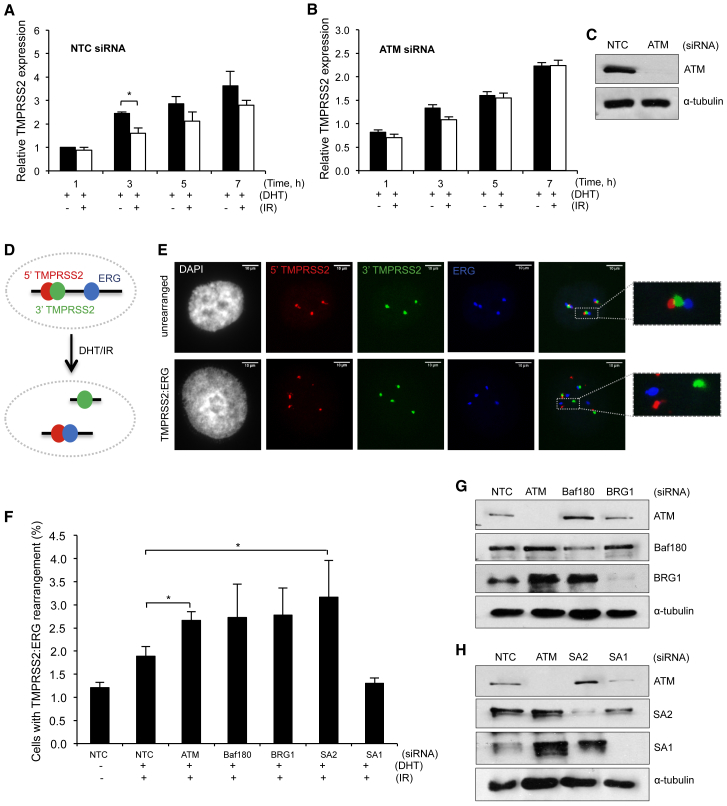
Depletion of Cohesin or PBAF Leads to Increased Chromosome Rearrangements in the TMPRSS2 Gene Following Transcriptional Induction and DNA Damage(A and B) qRT-PCR analysis of relative TMPRSS2 transcript levels in LNCaP cells following transcriptional induction with 300 nM DHT (+DHT) and with or without 10 Gy irradiation after siRNA depletion with non-targeting control (NTC; A) or ATM (B). Data are presented as the mean ± SEM; n = 3 biological repeats.(C) Western blot analysis of whole-cell extracts prepared from cells treated with siNTC or siATM. α-Tubulin was used as a loading control.(D) Cartoon of gene organization and location of probes used in FISH assays to monitor TMPRSS2:ERG translocations. Following treatment with DHT and IR, LNCaP cells underwent frequent rearrangements, as illustrated.(E) Representative FISH images showing cells with (bottom) and without (top) TMPRSS2:ERG translocations (see D).(F) Analysis of translocations between TMPRSS2 and ERG in LNCaP cells by FISH following transcription activation and DNA DSB induction in cells treated with the indicated siRNA. 50 cells were analyzed per condition per repeat. Data are presented as the mean ± SEM, and a minimum of 3 (up to 12) biological repeats were performed for each condition.(G and H) Western blot analysis of whole-cell extracts prepared from LNCaP cells treated with siRNA targeting ATM, BAF180, or BRG1 (G) or ATM, SA2, or SA1 (H). NTC, non-targeting control. α-Tubulin was used as a loading control.∗p < 0.05, ∗∗p < 0.01 using unpaired Student’s t test. See also Figure S5.